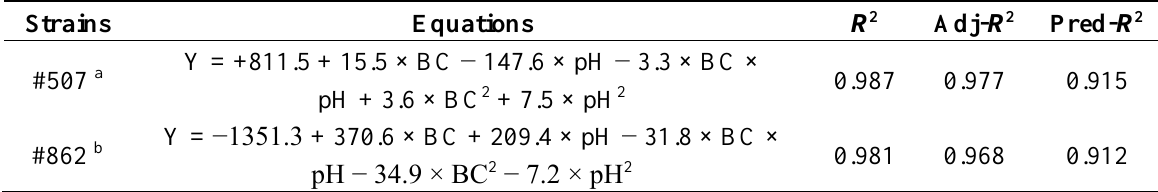
Table 3. The final equation in terms of the actual factors.